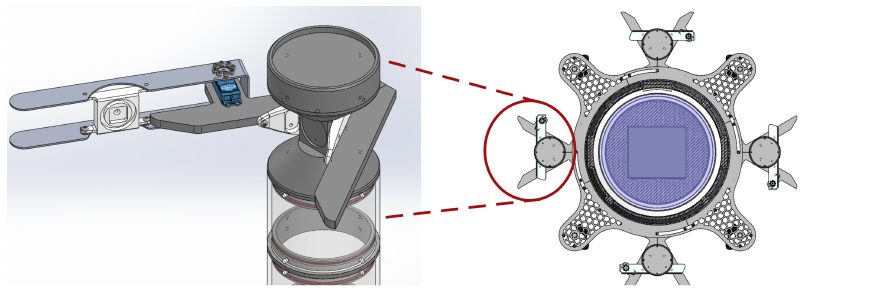
Figure 3. aPad docking mechanism design. Details show an aMussel top cap being